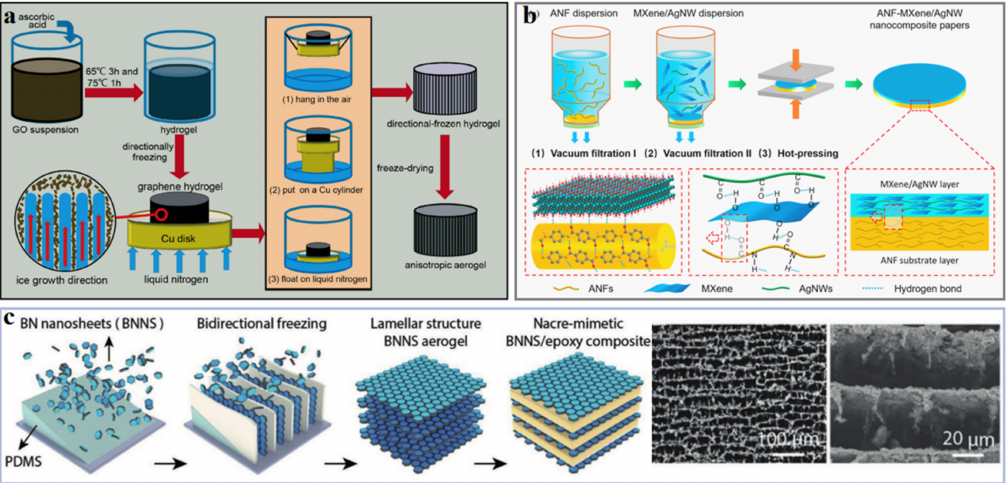
Figure 5. Schematic diagrams of thermally conductive polymer composites with high thermal conductivity by adding ( a ) carbon material [53] (Copyright (2018) with permission from Elsevier Ltd.), ( b ) metals [55] (Copyright (2020) with permission from American Chemical Society) and ( c ) ceramics [67] (Copyright (2019) with permission from Wiley Periodicals,